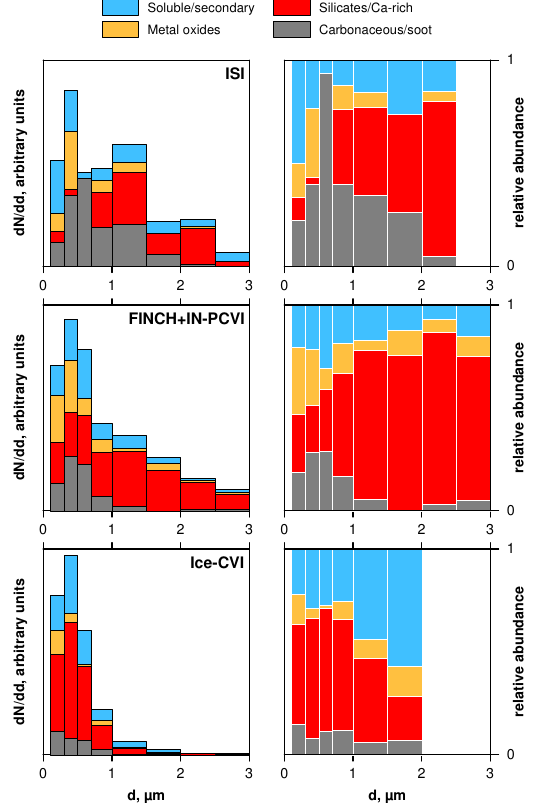
INP/IPR components for ISI, FINCH + IN-PCVI and Ice-CVI. Par- ticle groups were combined according to potential sources to obtain a sufficient number of particles in each size interval. Left column: number size distribution in dN/dd (number density per size inter- val). Note that the different size distributions cannot be compared directly due to different instrumental inlet and transmission efficien- cies. Right column: relative number abundance. Size intervals with less than 15 particles are not